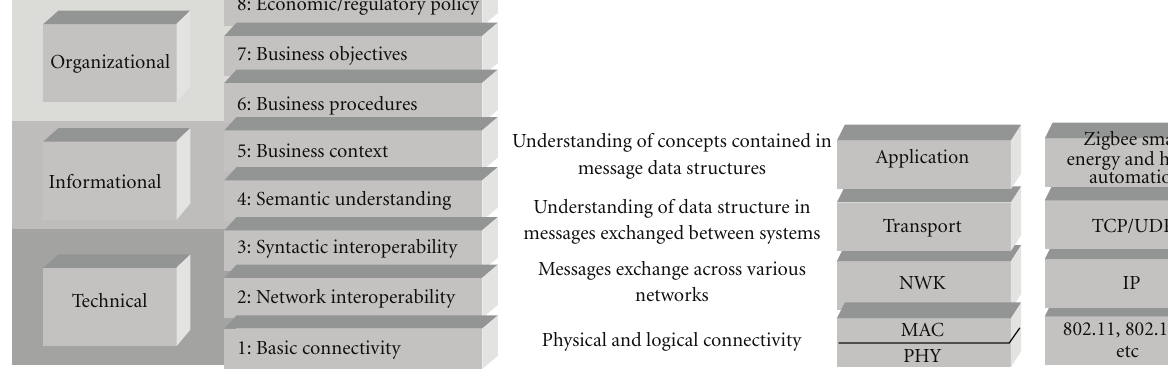
Figure 5: Interoperability network architecture.